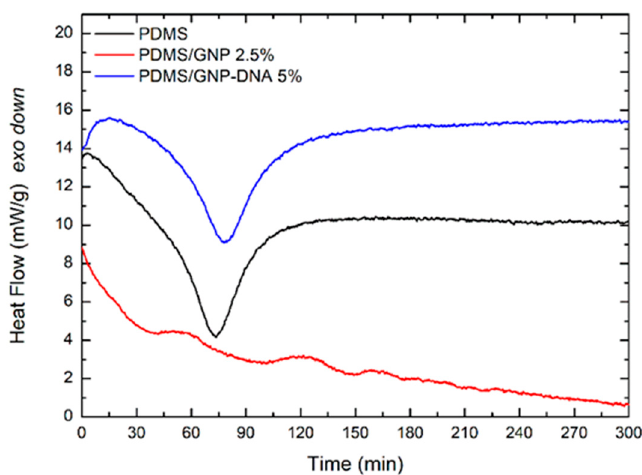
Figure 5. Isothermal DSC analysis (T = 50 ◦ C) of the cure kinetics of PDMS prepolymer and PDMS nanocomposite mixtures filled with 2.5 wt% GNP and 5 wt% GNP–DNA.